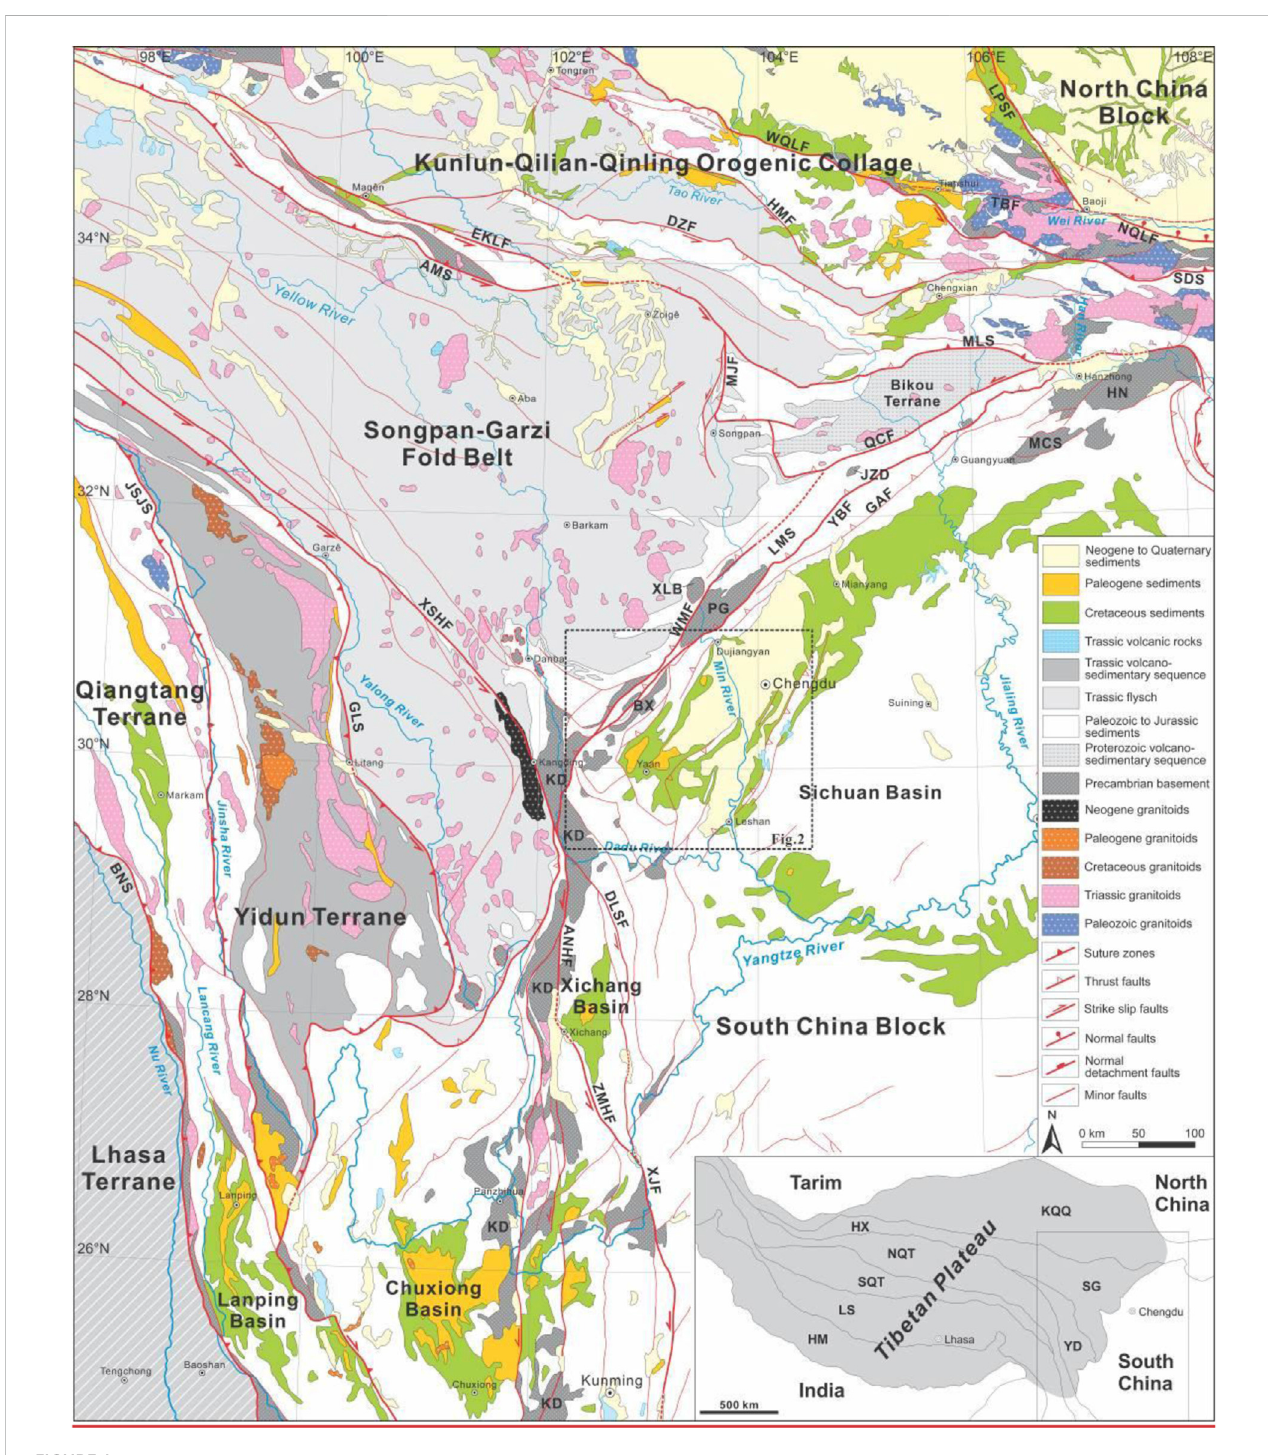
FIGURE 1 Simpli fi ed geological and structuctural map of the eastern Tibetan Plateau (after Liu et al., 2019).